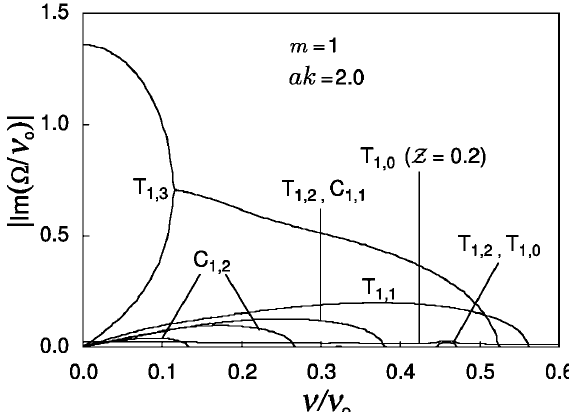
FIG. 4. Absolute value of the imaginary part of (cid:13) =(cid:10) for the o for ak (cid:3) 2 : 0 , b=a (cid:3) first 16 dipole modes as a function of (cid:10)=(cid:10) o 1 : 5 , and zero wall impedance. Only the modes with none-zero (cid:2) are labeled. Also shown is the absolute value of Im (cid:1) (cid:13) =(cid:10) o of the T mode for the case of the imaginary part of (cid:13) =(cid:10) o 1 ; 0 Z (cid:3) 0 : 2 .